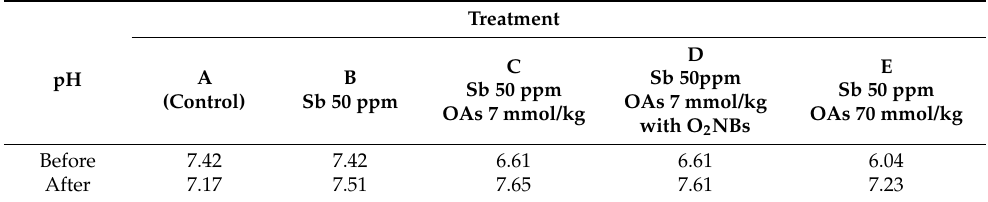
Table 1. Measurement of pH before and after the experiment for all